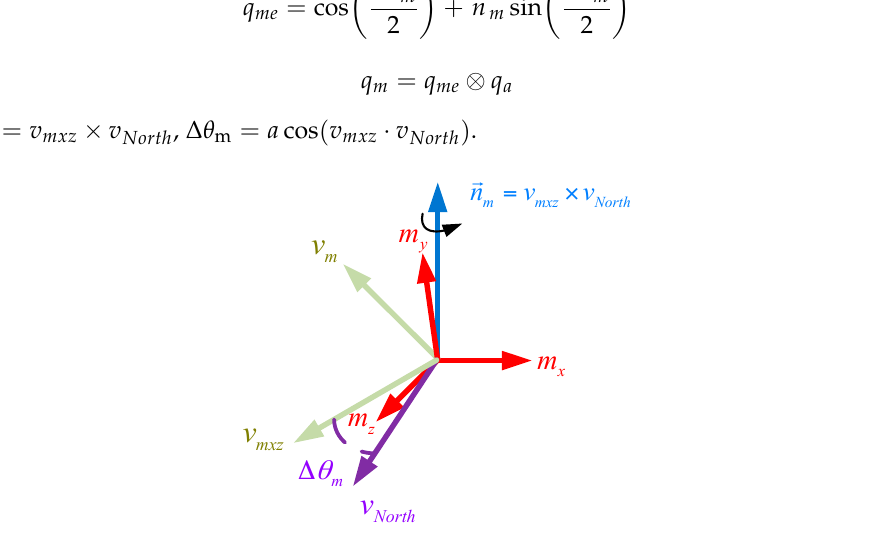
Figure 4. Correcting the estimated direction of the magnetic field using magnetometer.